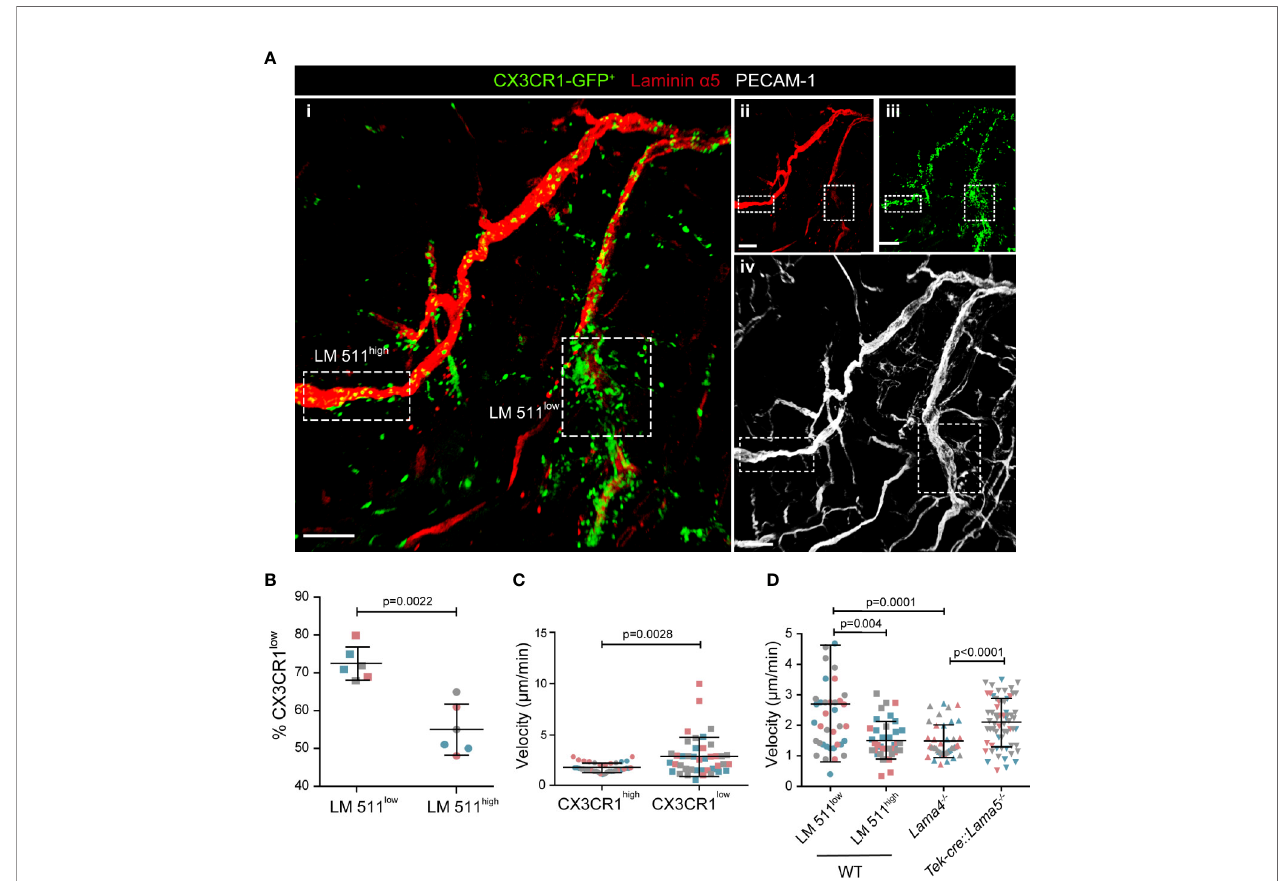
FIGURE 2 | CX3CR1-GFP low in fl ammatory monocytes preferentially extravasate at laminin 511 low sites. (A) Representative confocal microscopy of whole mount cremaster muscle from a WT host carrying CX3CR1 GFP/+ bone marrow stained with anti-laminin a 5 and anti-PECAM-1 antibodies (i); single channel images are shown in (ii, iii, iv); scale bar = 100 m m. Experiment was repeated three times with one animal with the same results. (B) To track CX3CR1-GFP low in fl ammatory monocytes GFP mean fl uorescence intensity (MFI) was measured in situ in areas of high and low laminin 511 expression (see Fig. S2A), revealing a higher proportion of CX3CR1-GFP low cells, expressed as a percent of total GFP + cells, at laminin 511 low compared to laminin 511 high sites; data are means ± SD of three mice from three separate experiments and at least fi ve postcapillary venules in two different areas/mouse; different experiments are marked by different colors. (C) Quanti fi cation of GFP MFI and migration speed of individual CX3CR1 high and CX3CR1 low cells analyzed in three WT hosts from three separate experiments. (D) Average migration velocities of extravasating GFP + cells at laminin 511 low and high sites in WT controls, and in Lama4 − / − and Tek-cre::Lama5 − / − chimeras. Data in (C, D) are means ± SD calculated from 39-64 cells analyzed in three mice per chimera (marked by different colors); movies were captured at 4 h post-administration of CCL2. Signi fi cance of data in (B – D) were calculated using Mann-Whitney tests since the data did not pass the normality test by D`Agostino & Pearson; the exact p -values are shown in the